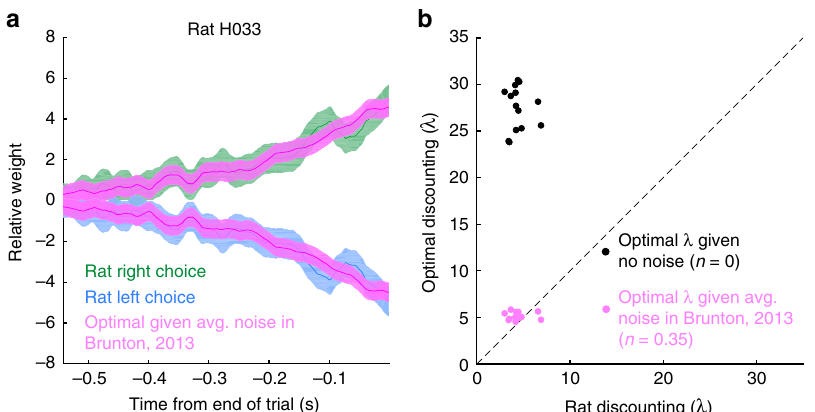
Fig. 4 Rats discount evidence with the optimal timescale. a Example reverse correlation curve for one rat (blue and green), and the reverse correlation curve from the optimal linear inference agent (pink) with the average rat sensory noise from Brunton, 2013 12 . The optimal linear inference agent was simulated on the same trials the rat performed. Shaded area shows one standard deviation. b Quanti fi cation of discounting timescales. Rat integration timescales plotted with optimal agents with no sensory noise (black), or with sensory noise (pink). The variability in optimal discounting rates is a result of measuring the reverse correlation curves on a different set of trials each rat actually performed. Error bars omitted for